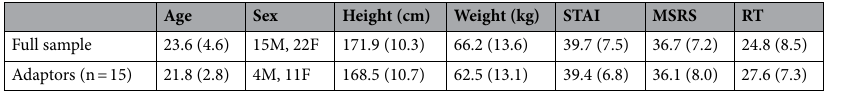
Table 1. Demographic and personality information for participants and adaptor subgroup. Values provided reflect means and standard deviations (with the exception of sex, in which case sums are provided). Scores range from 20–80 on the State-Trait Anxiety Inventory (STAI; higher scores reflect greater trait anxiety), 10–60 on the Movement-Specific Reinvestment Scale (MSRS; higher scores reflect greater propensity for movement reinvestment), and 6–42 on the Domain Specific Risk-Taking Scale (RT; higher scores reflect greater propensity for recreational risk-taking). Note, personality data were not collected for two participants, both of whom were in the Adaptor